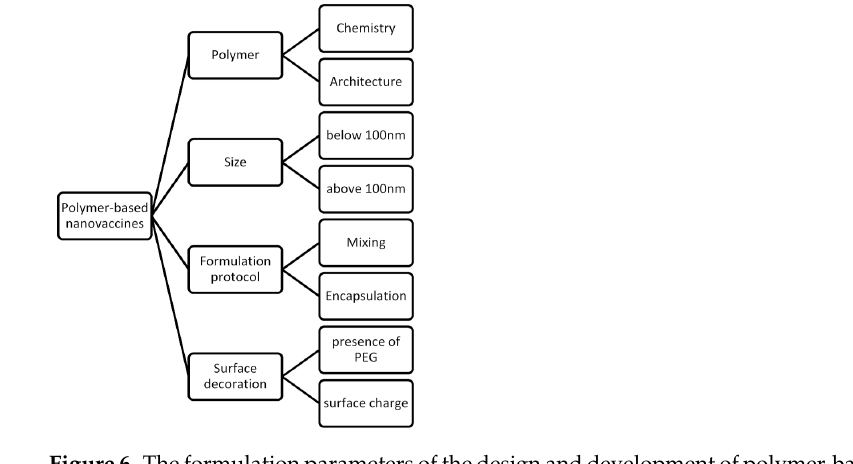
Figure 6. The formulation parameters of the design and development of polymer-based